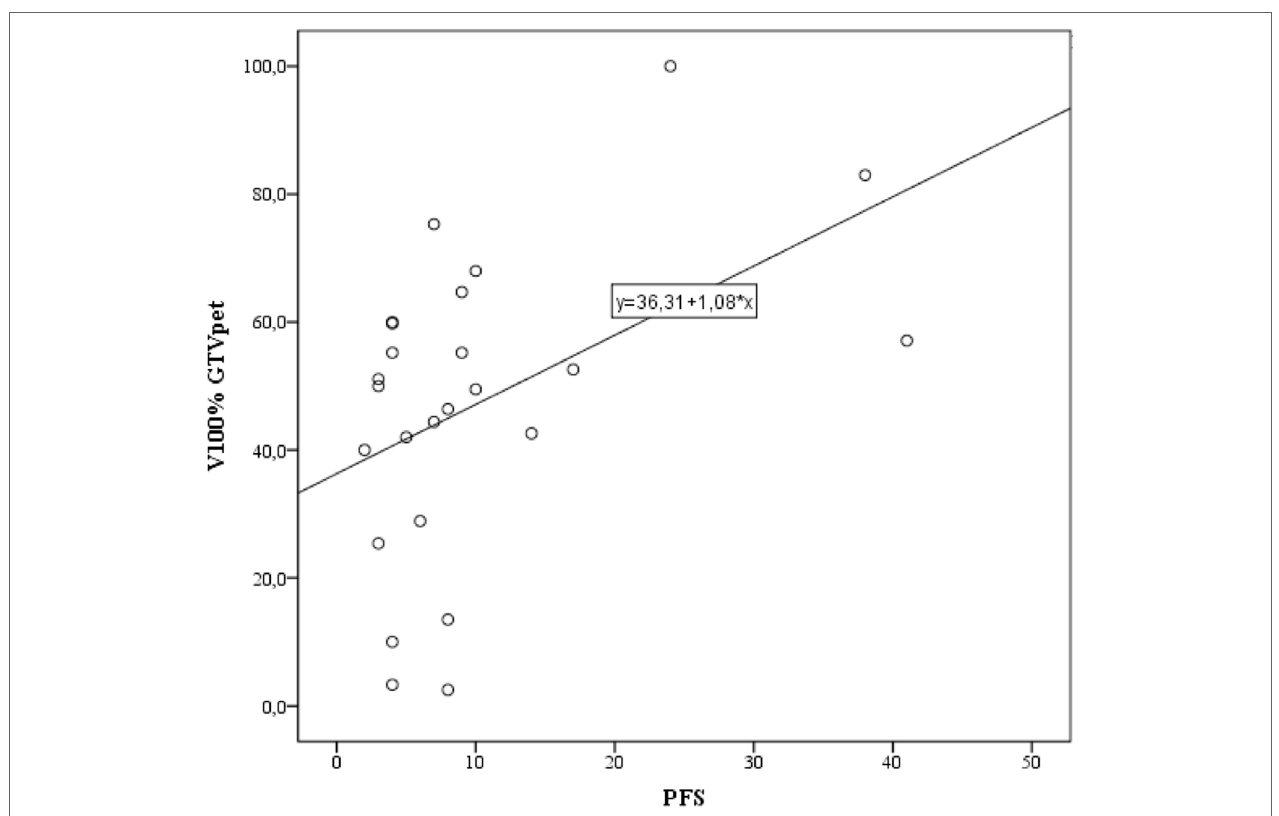
FigUre 4 | Correlation between V100% gross tumor volume (GTV) PET and progression-free survival (PFS). Simple linear regression performed using the least squares method with the regression function